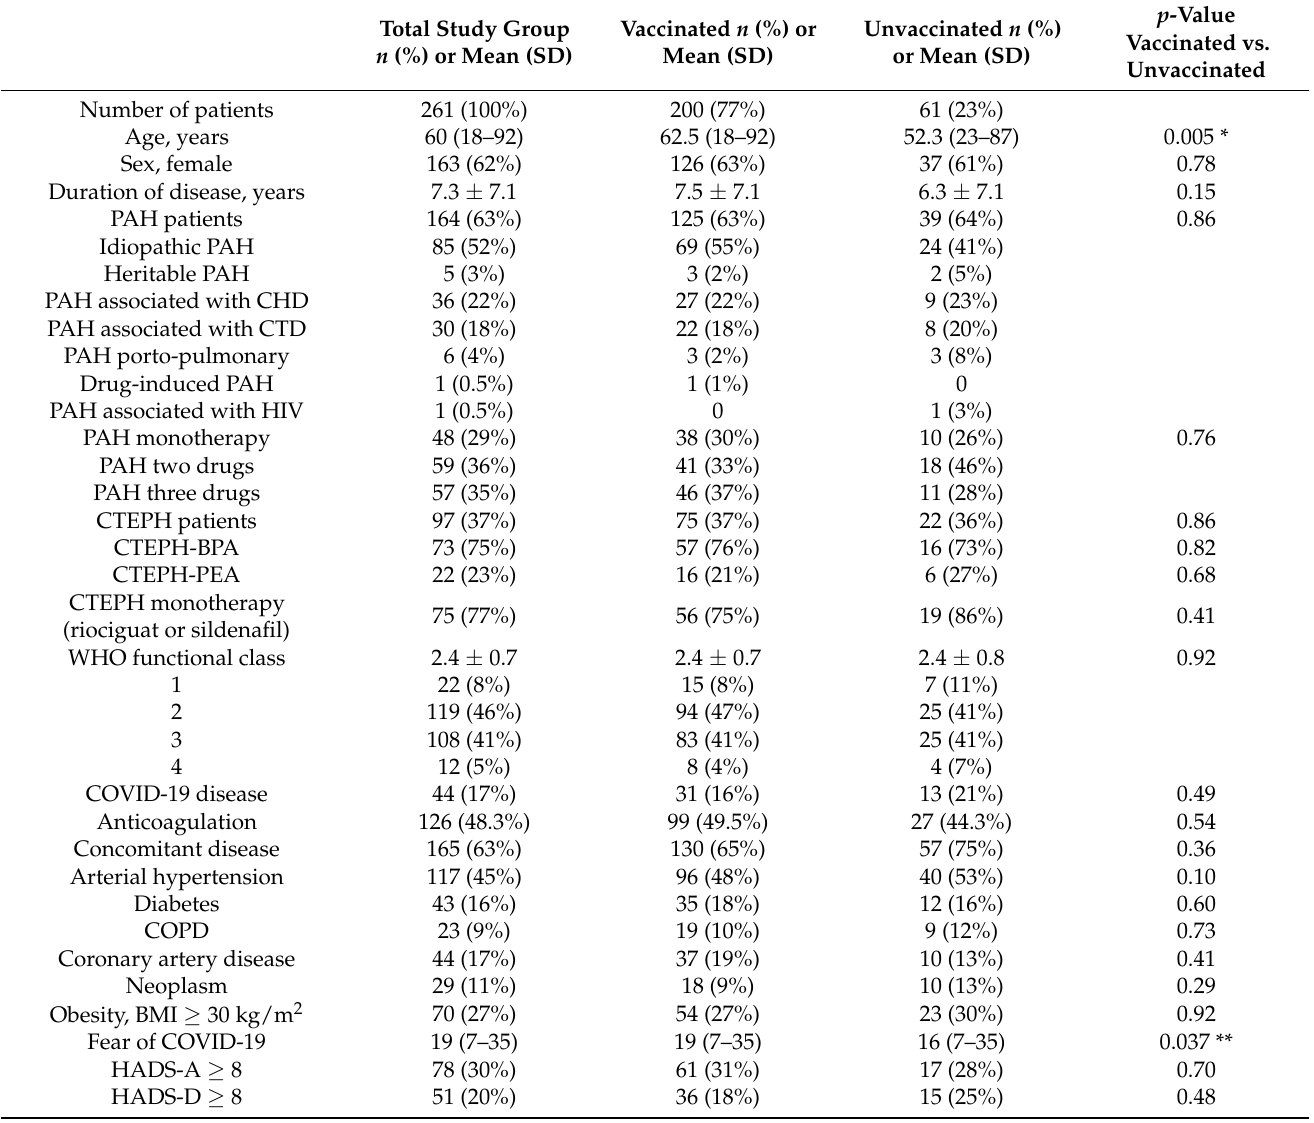
Table 1. Characteristics of the study group patients according to their decisions about vaccination against